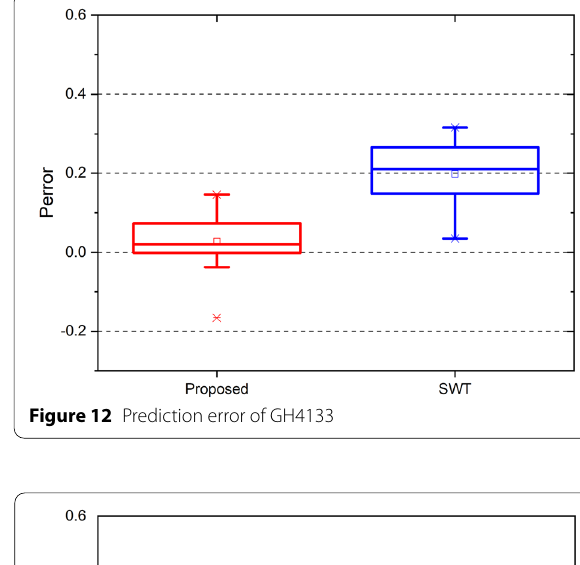
Figure 10 Predicted lives vs. tested lives of GCr15 at contact test